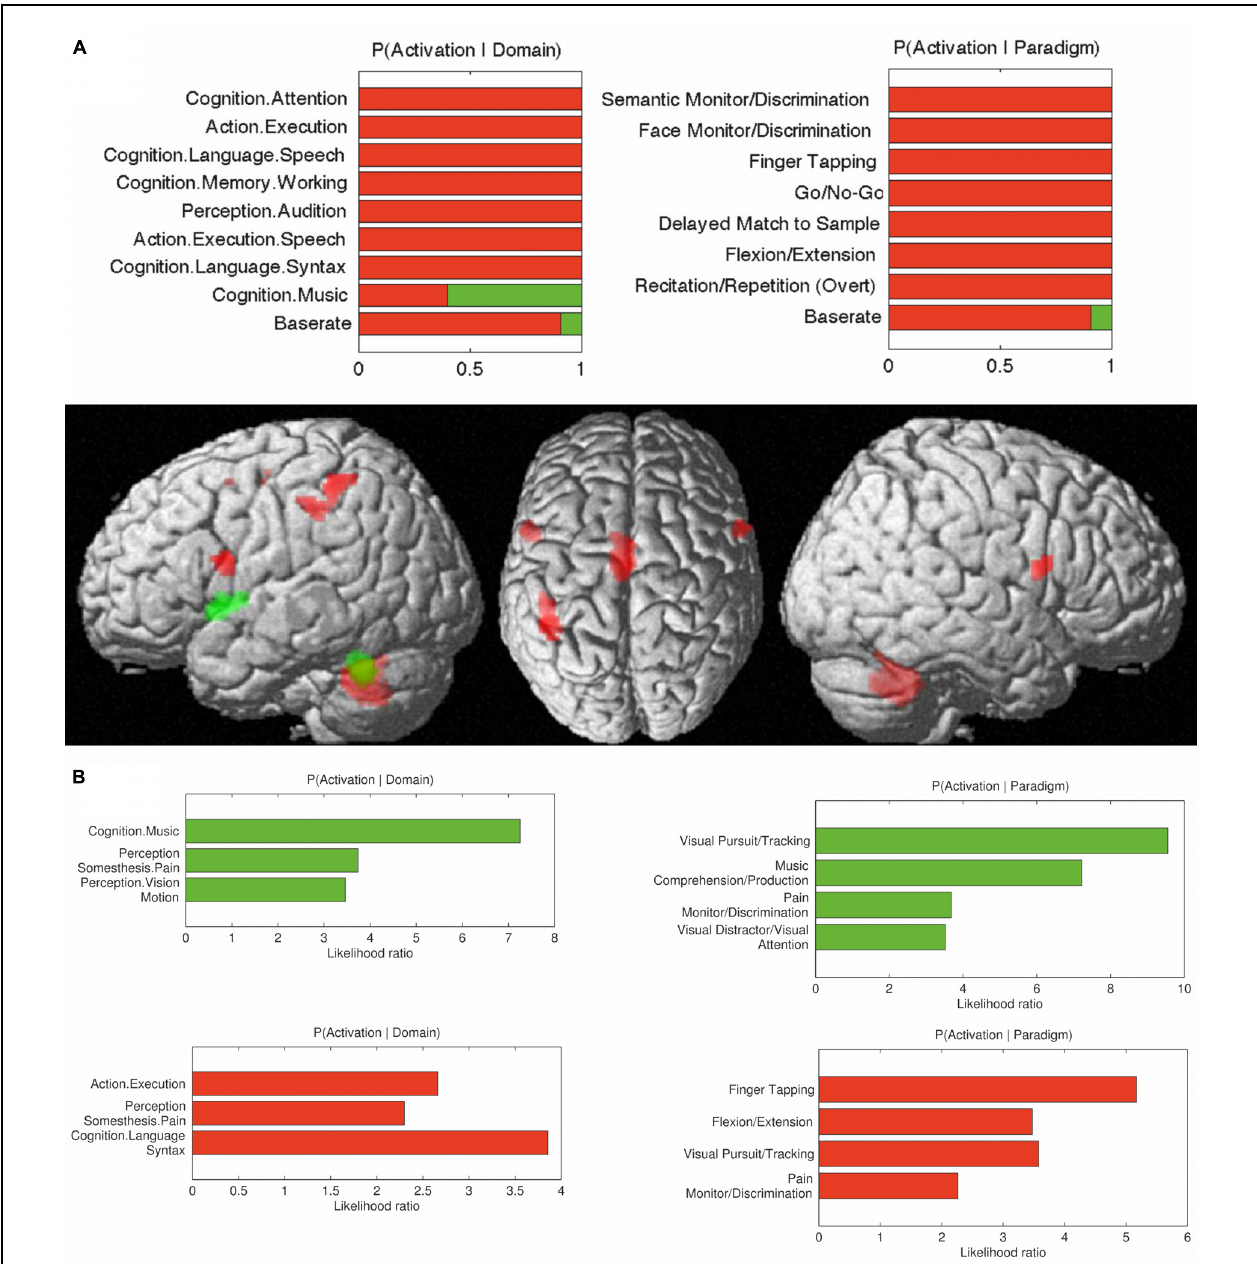
FIGURE 6 | (A) Contrasts in behavioral domains between cerebellar interposed (green) and the dentate (red) nuclei ( p FDR < 0.05); (B) Behavioral domain information for the cerebellar interposed (green) and the dentate (red) nuclei ( p FDR <